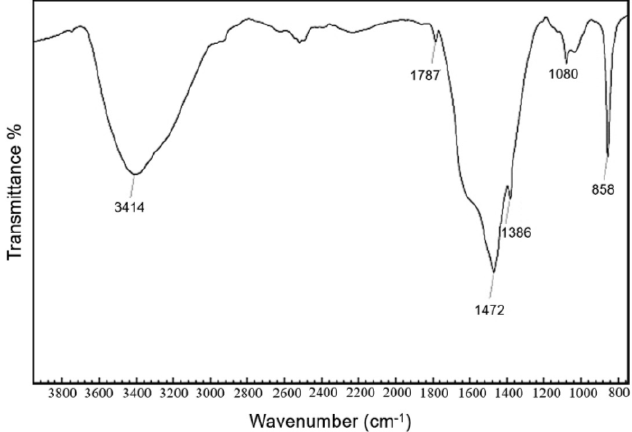
Figure 9. FT-IR spectrum of Pd/coral reef nanocomposite.